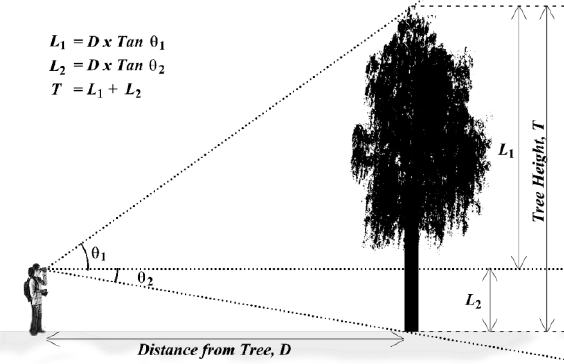
Figure 5. Tangent method that was used for calculating the tree